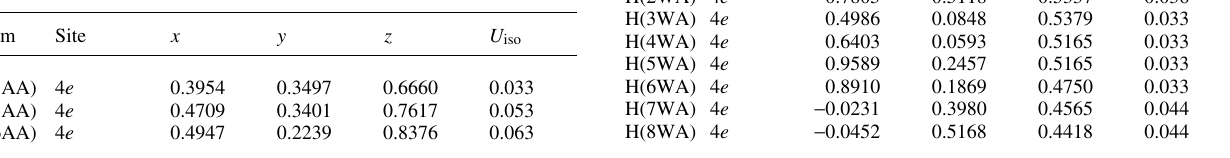
Table 2. Atomic coordinates and displacement parameters (in Å 2 ) .